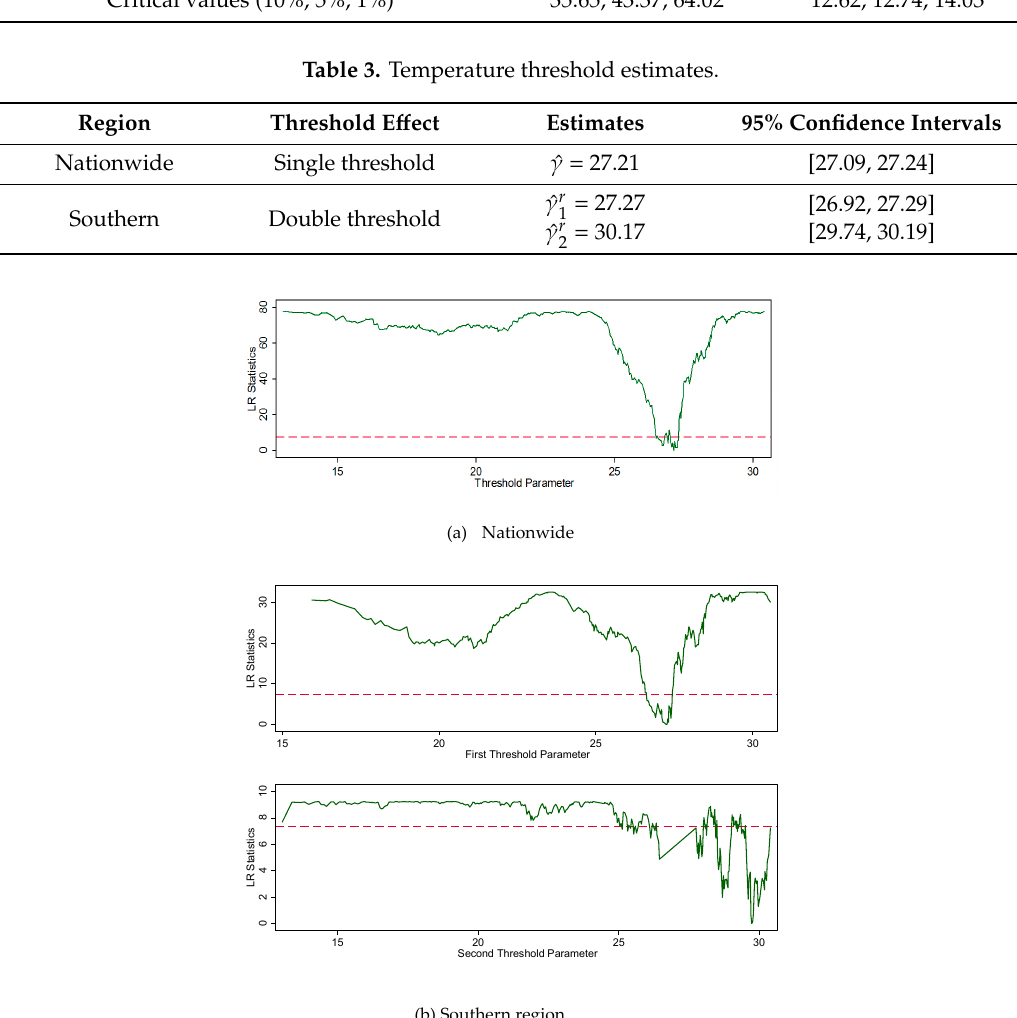
Figure 1. Confidence interval construction for (a) Nationwide (single) and (b) Southern region (double) thresholds. Note: The dash lines denote the critical value (7.35) at the 95% confidence level.